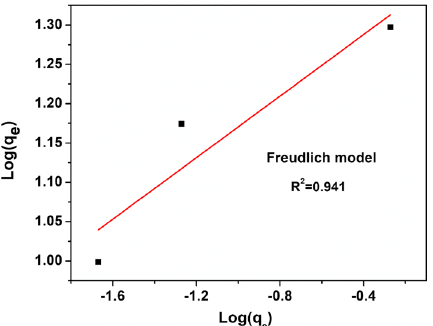
Fig. 8 Effect of adsorbent dose on Cr(VI) (10 ppm) adsorption